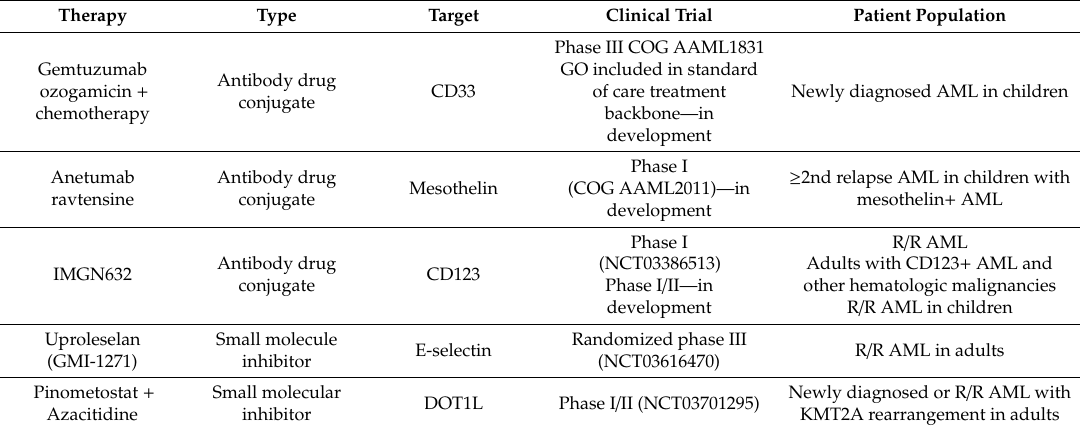
Figure 1. Schematic illustration of targetable pathways and drug mechanisms in pediatric acute myeloid leukemia (AML). Table 1. Selected novel AML therapies currently in clinical trials in children and